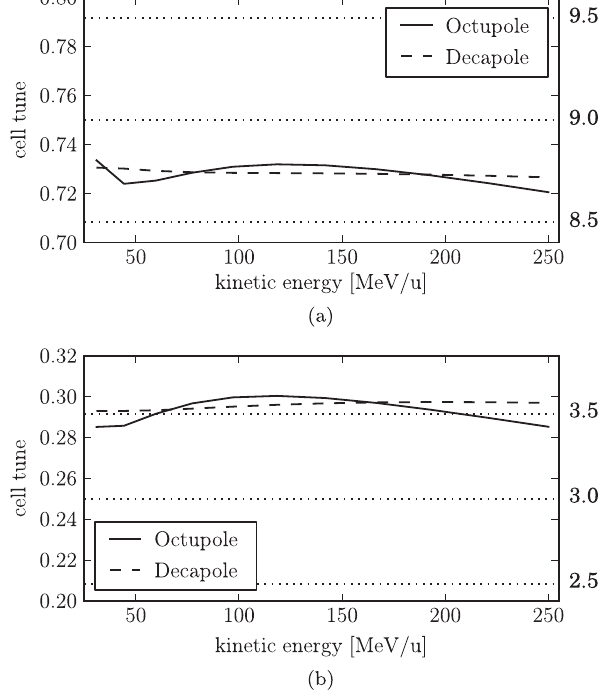
FIG. 5. Cell tunes for the proton ring throughout acceleration for the case of rectangular shaped magnets using a polynomial fit to the ideal field profile. The three magnets are aligned parallel with each other. Horizontal cell tune in (a) and vertical cell tune in (b). Dashed lines and associated numbers show total tune of a 12 cell